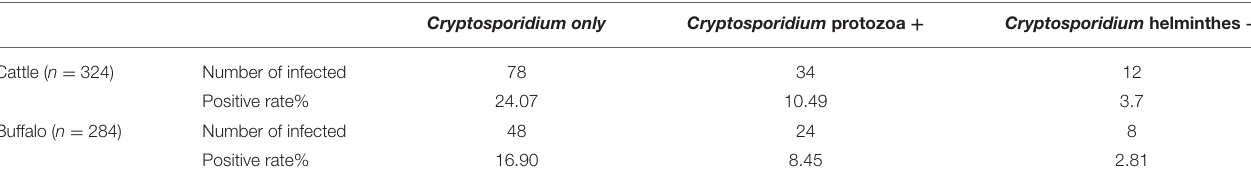
TABLE 4 | Mixed infection of Cryptosporidium with different parasites in examined cattle & buffalo